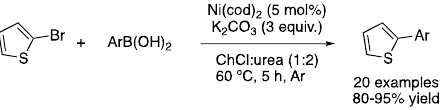
Figure 22. Application of Suzuki coupling to benzodithiophene derivatives.